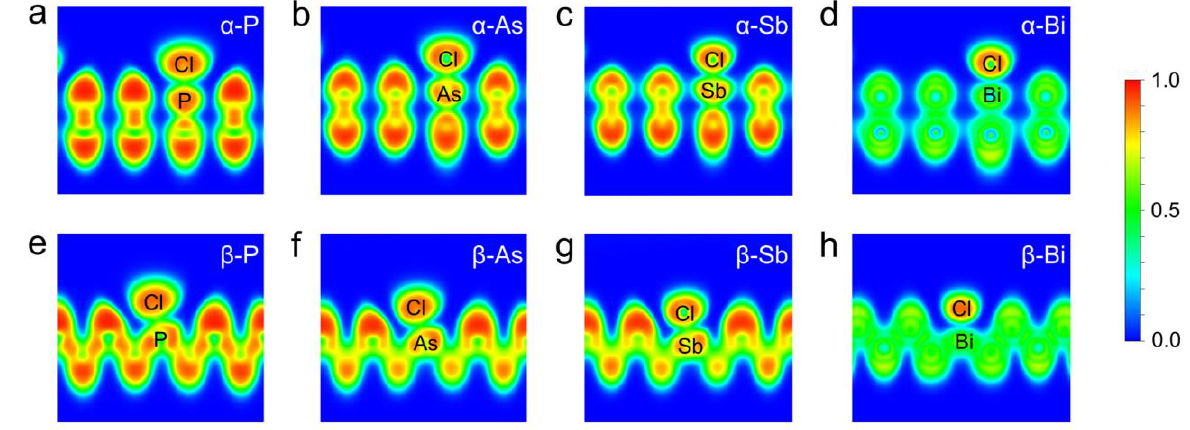
Figure 4. The electron localization functions for ( a ) α-phosphorene; ( b ) α-arsenene; ( c ) α-antimonene; ( d ) α-bismuthene; ( e ) β-phosphorene; ( f ) β-arsenene; ( g ) β-antimonene; and ( h ) β-bismuthene monolayers with the adsorbed Cl atom.